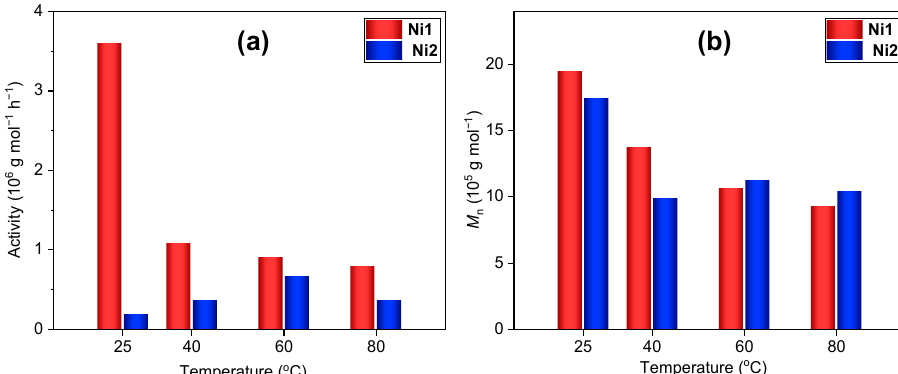
Figure 4. Comparison of ( a ) activity and ( b ) molecular weight M n of Ni1 and Ni2 systems at different temperatures.